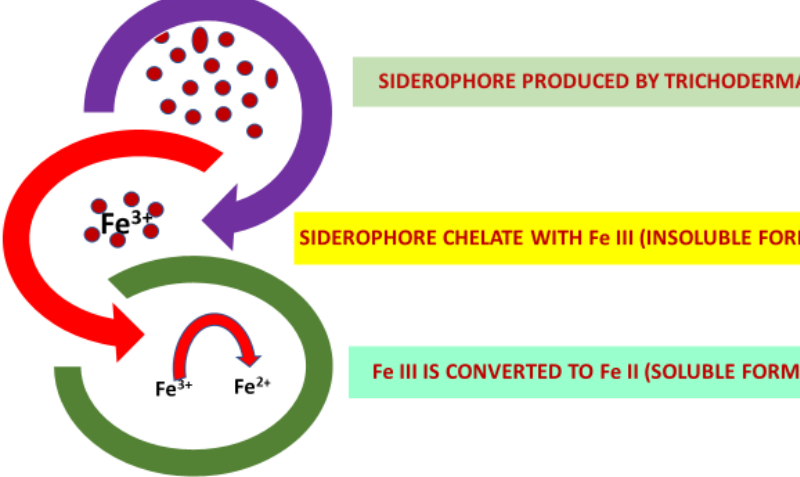
Figure 2. In plant rhizosphere Trichoderma produces a siderophore which chelates insoluble Fe ( Fe 3+ ) and facilitate its conversion to soluble Fe ( Fe 2+ ) form. By doing this, Trichoderma also make Fe source unavailable to pathogenic fungi and thereby deprive them of Fe.